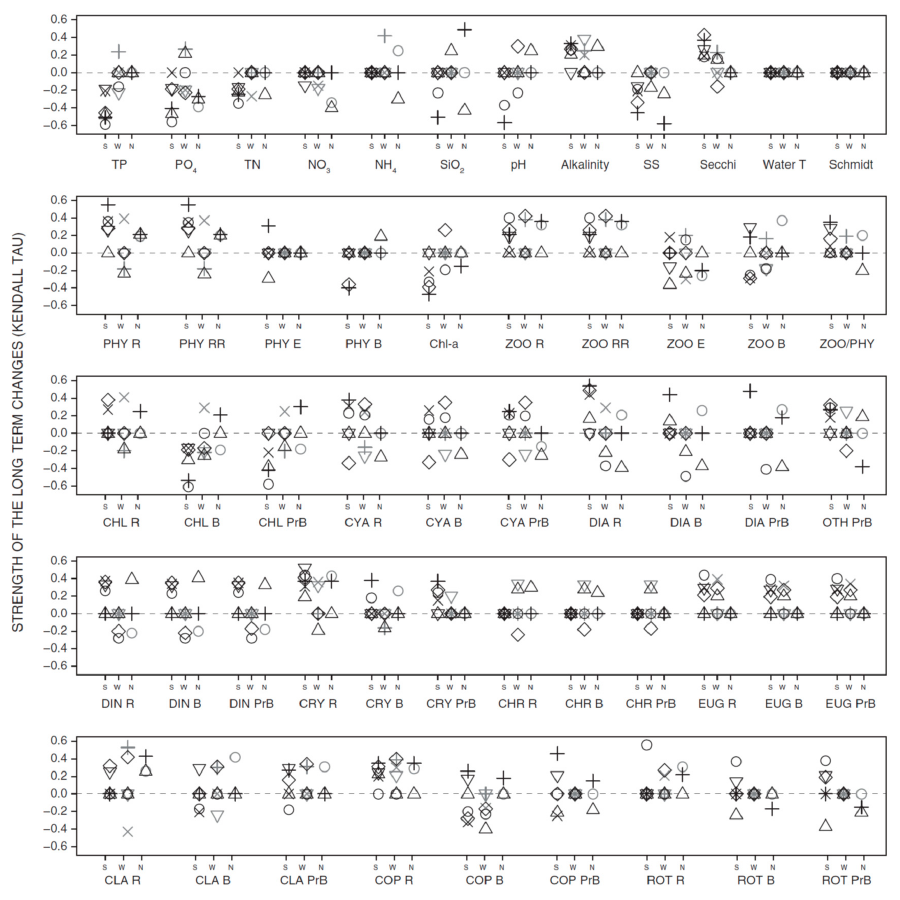
Figure A8. Summary of monotonic long ‐ term trends in lake and plankton variables analysed for autumn. For details see Figure 4.